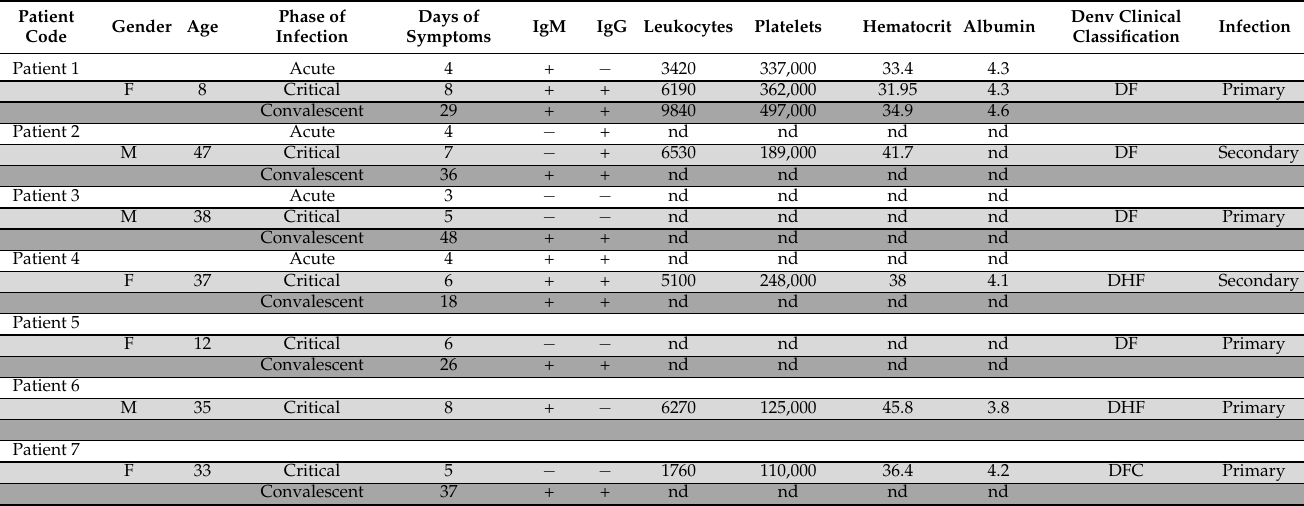
Table 1. Dengue fever, complicated dengue fever, and dengue hemorrhagic fever patients. All samples were positive for DENV3